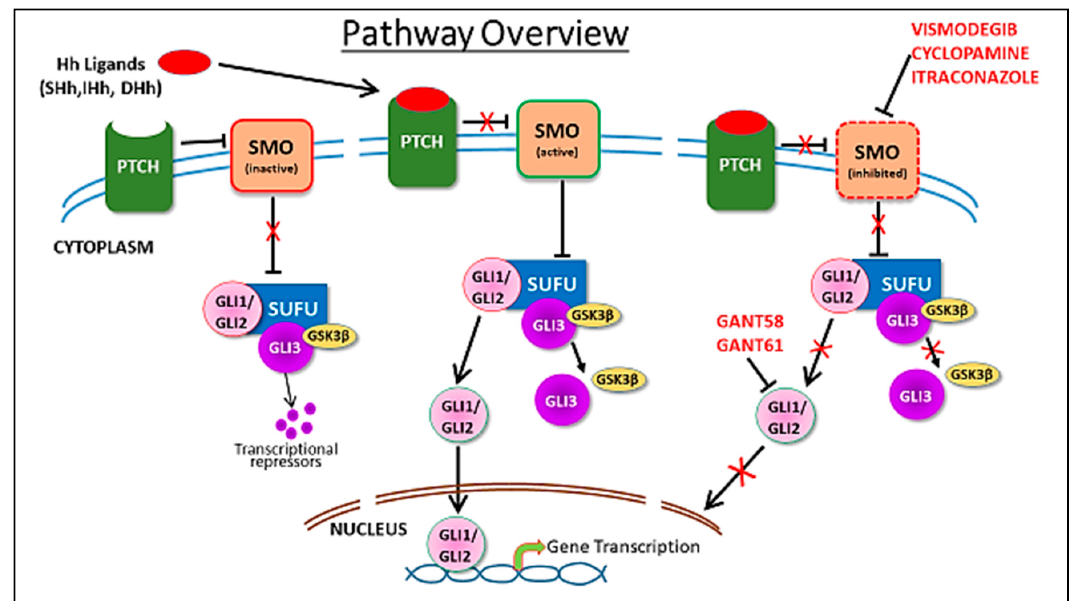
(Figure 2) [15,33–35]. Paracrine signaling and activation of the Hh pathway in stromal cells by ligand overexpression in tumor cells leading to increased invasiveness and metastasis has been described for breast cancer and pancreatic cancer [36,37].